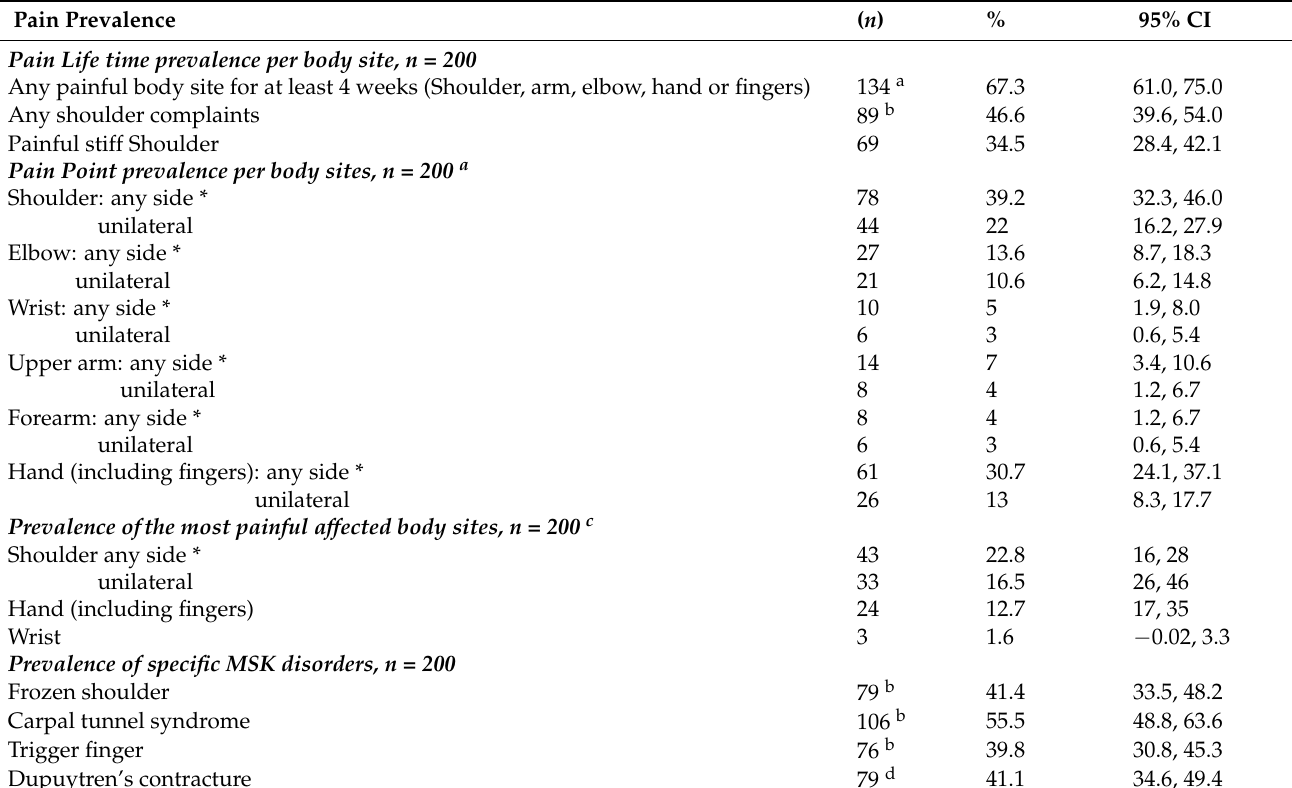
Table 4. Prevalence of specific upper extremity musculoskeletal disorders on complaint or diagnosis level in patients with type 2 diabetes in the questionnaire